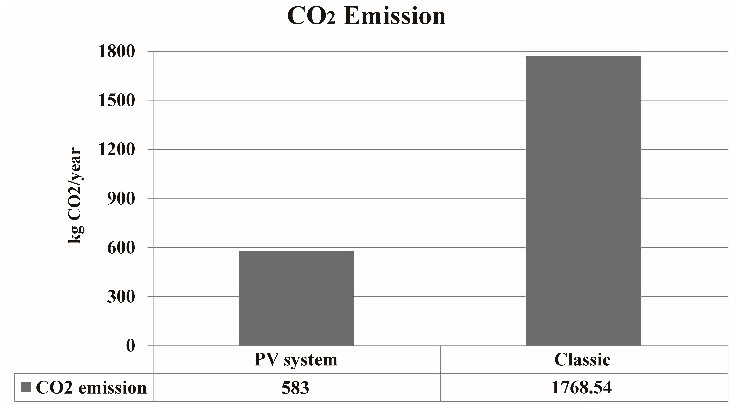
Figure 10. Carbon dioxide emissions.